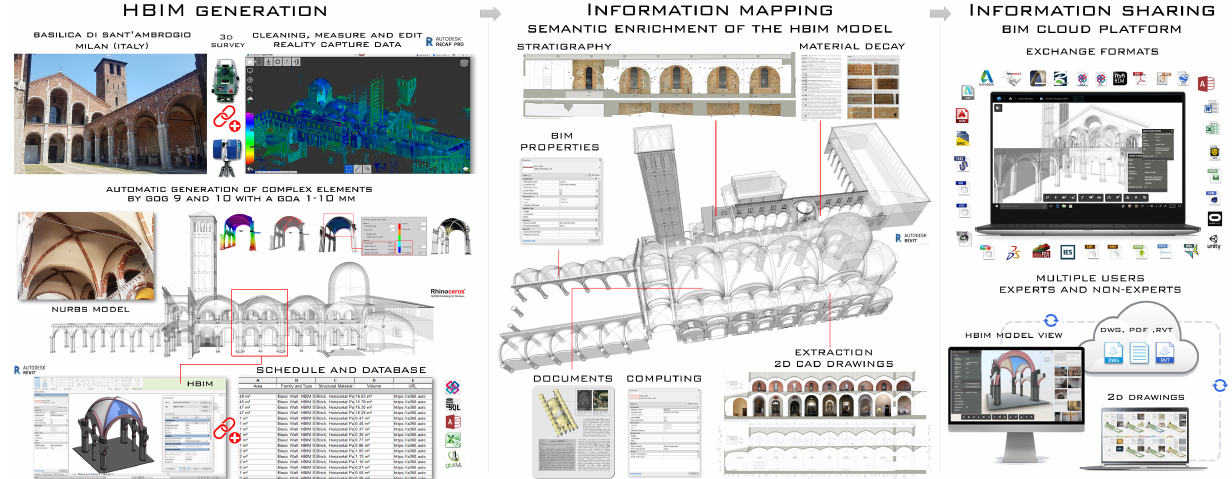
Figure 6. The three steps applied to the HBIM model: thanks to an 'informative' HBIM model and a BIM cloud platform, it has been possible to improve the level of information for the different type of